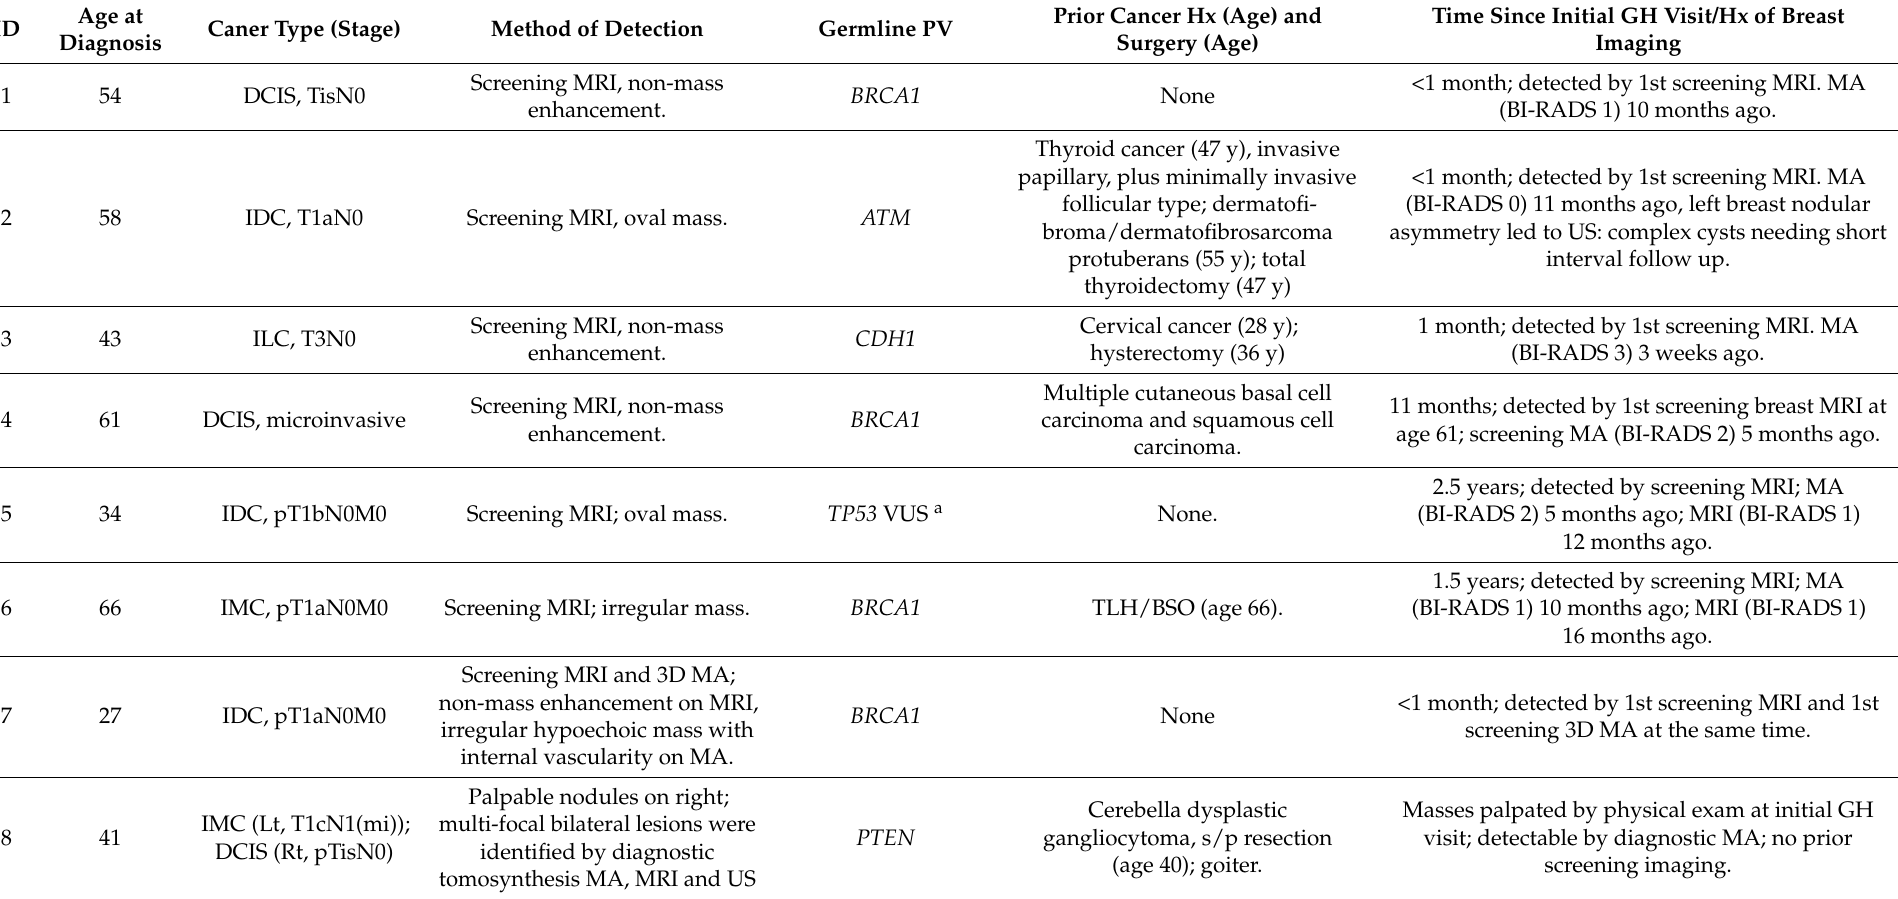
Table 5. Malignant and premalignant breast lesions discovered during GeneHome follow